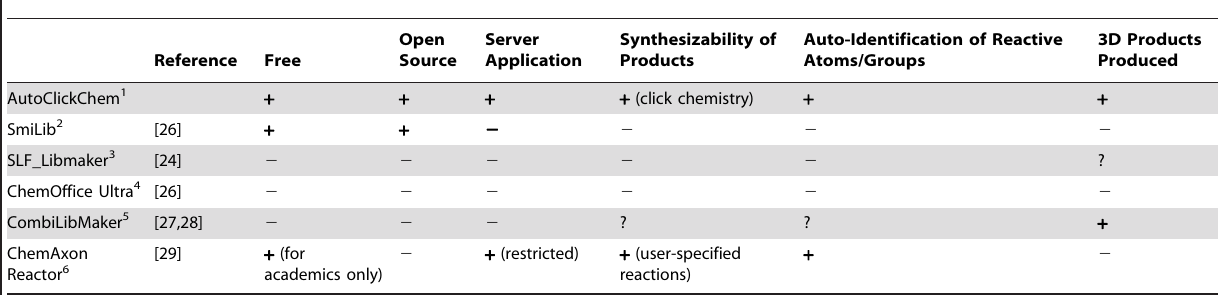
Table 1. A comparison of several computer programs for virtual combinatorial-library